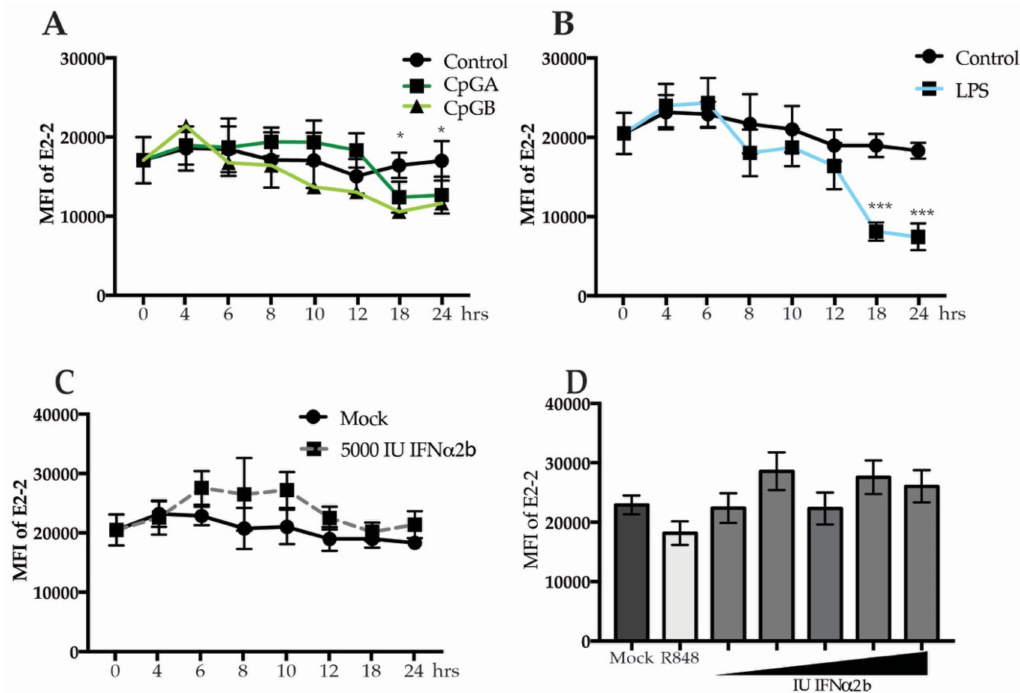
Figure 3. IFN α receptor signaling does not diminish E2-2 expression. PBMCs were treated with 5 ug / mL of CpGA or CpGB ( A ), 200 ng / mL lipopolysaccharide (LPS), ( B ) or 5000 IU recombinant IFN α 2b ( C ) for up to 24 h. ( D ) PBMCs were treated with 10, 100, 1000, 5000, or 10,000 IU of IFN α 2b for 24 h. n = 5 independent experiments. Data are presented as means ± SEM. p values < 0.05 were considered significant. * p < 0.05, ** p < 0.01, *** p <